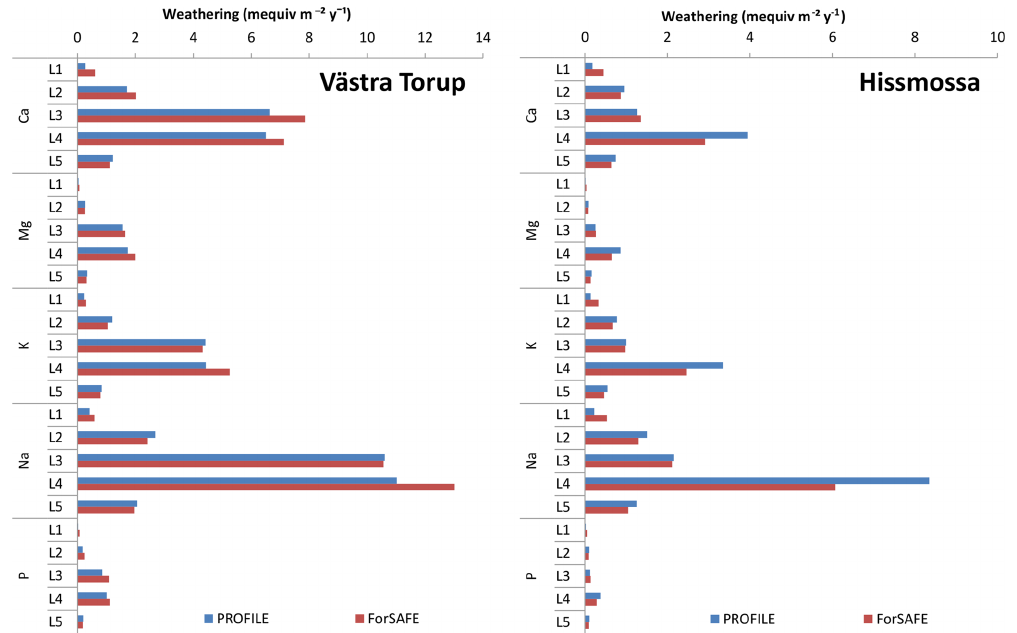
Figure 1. Weathering rates (mequivm − 2 yr − 1 ) calculated with the PROFILE model and the ForSAFE model (averages over a forest rotation, BSC scenario), for the sites at Västra Torup and Hissmossa and for soil layers from L1 (top layer) to L5 (bottom layer at ∼ 50cm depth). The time period is from one clear cut to the next and is different for the two sites: 2011–2080 for Västra Torup and 2041–2100 for Hissmossa. Note that the rates are shown here per layer so that the bars show directly how much of the total weathering each soil layer contributes. For Hissmossa, L5 is shown, even though it lies below the root zone and is not included in calculations of weathering rates in the root